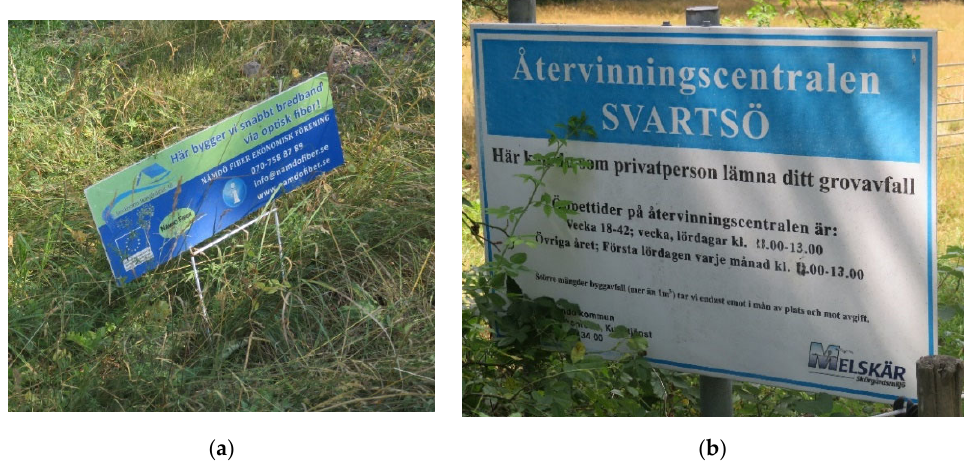
Figure 4. Examples of signs addressing the everyday life of permanent residents: ( a ) A sign about the broadband connection being built on Nämdö; ( b ) the information sign by the recycling centre on Svartsö.